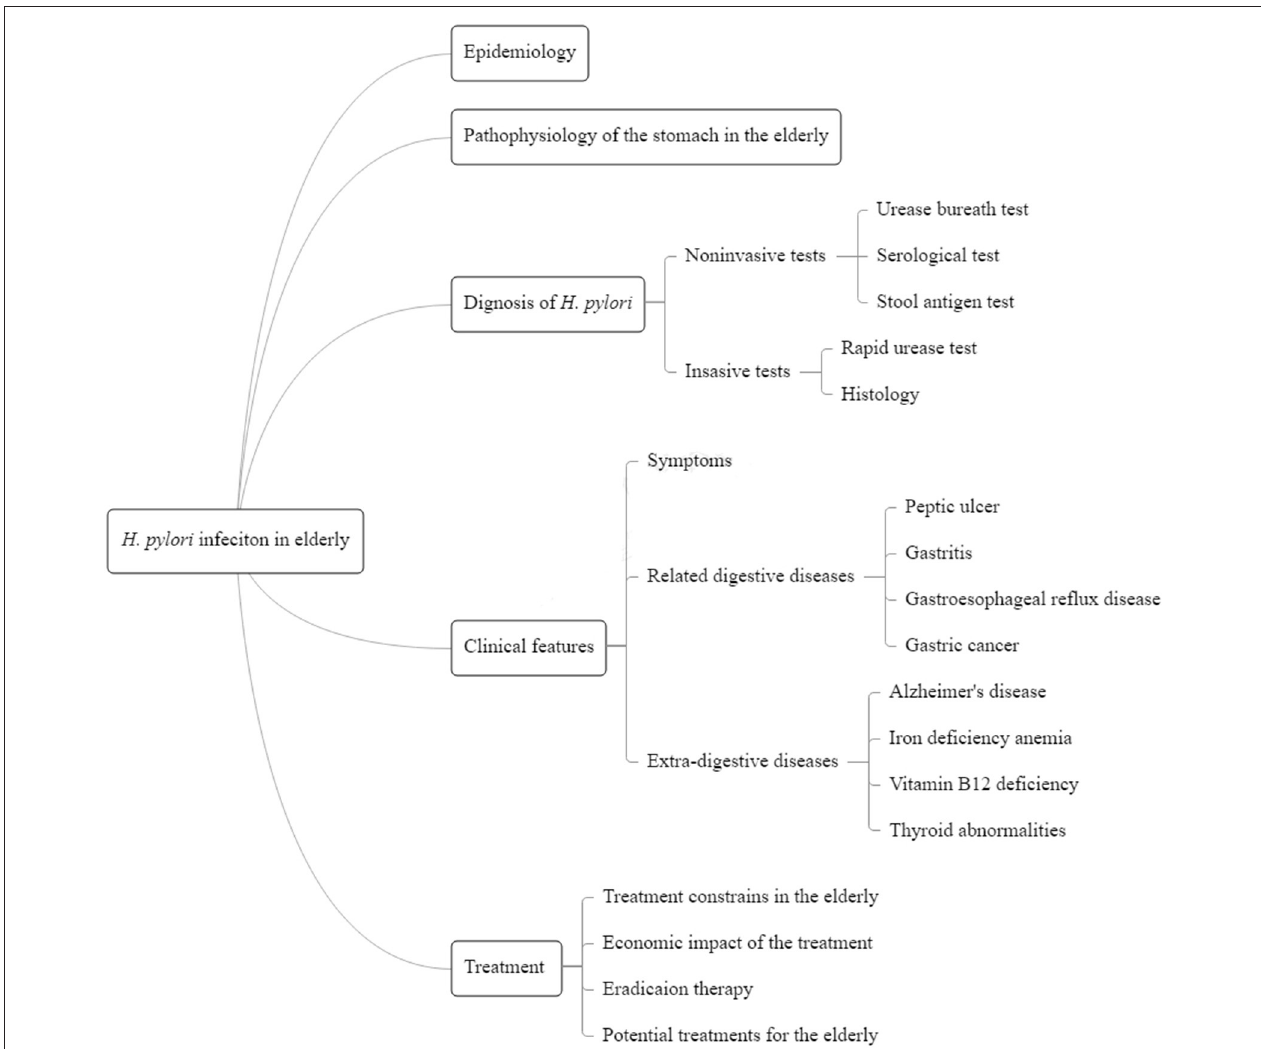
FIGURE 1 | Summary figure of the